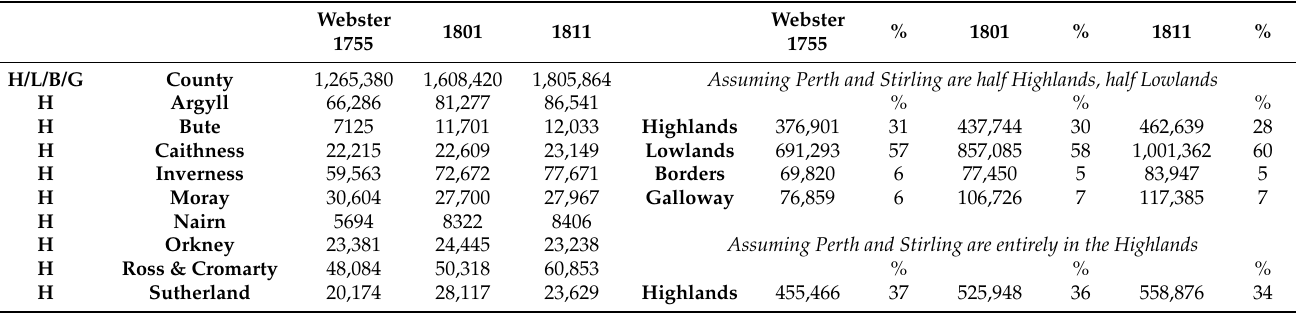
Table 2. The populations of counties, then summed into the regions Highlands (H),